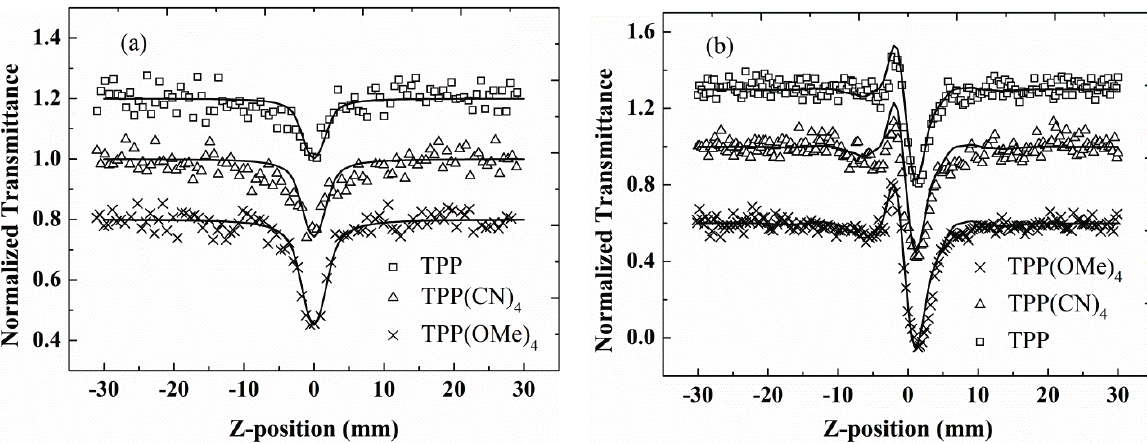
Figure 5. Open ( a ) and closed aperture ( b ) Z-scan data of TPP, TPP(CN) 4 , and TPP(OMe) 4 with 6 ns pulses, on-axis intensity 27 MW/cm 2 . Solid lines are theoretical